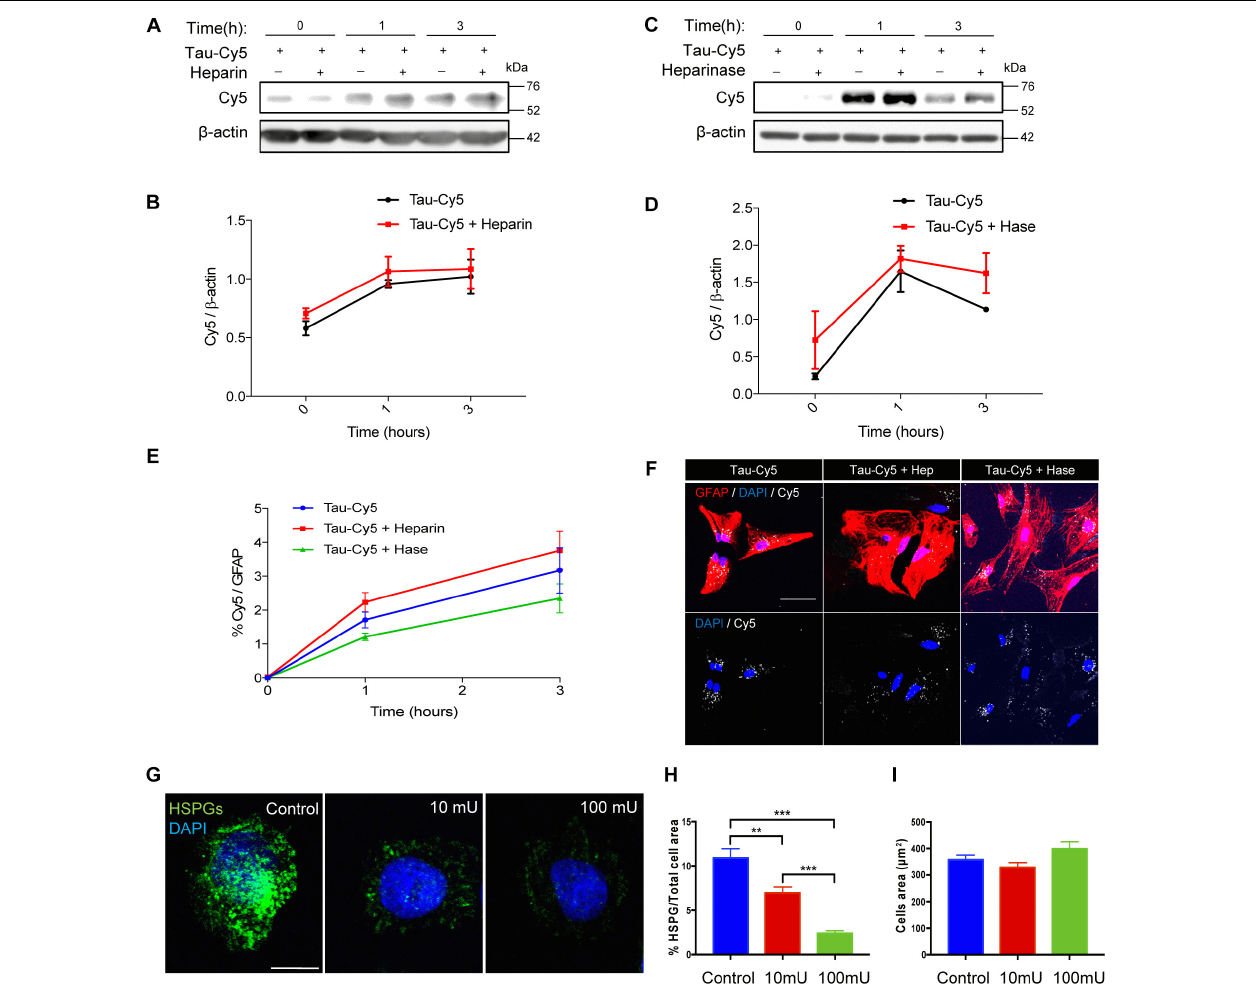
FIGURE 2 | Internalization of monomeric Tau in astrocytes is not through heparan sulfate proteoglycans. Representative western blot (A) and quantification (B) of the time course of Tau-Cy5 internalization from 0 to 3 h in the presence or absence of heparin. Cells were treated with Tau-Cy5 (control, T) or Tau-Cy5 + heparin (T+Hep) for different times, and Cy5 was analyzed in cell lysates. Note that the internalization of Tau did not change in the presence of heparin. Means and SE, T 0 h = 0.58 ± 0.06; T+Hep 0 h = 0.71 ± 0.04; T 1 h = 0.96 ± 0.03; T+Hep 1 h = 1.06 ± 0.13; T 3 h = 1.02 ± 0.15; and T+Hep 3 h = 1.09 ± 0.17. Representative western blot (C) and quantification (D) of Tau-Cy5 with (T+Hase) or without heparinase treatment (T) from 0 to 3 h. Means and SE: T 0 h = 0.23 ± 0.04; T+Hase 0 h = 0.72 ± 0.4; T 1 h = 1.65 ± 0.28; T+Hase 1 h = 1.82 ± 0.17; T 3 h = 1.13 ± 0.03; and T+Hase 3 h = 1.62 ± 0.27. Note that the internalization of Tau did not change after the treatment with heparinase. Quantification of Tau-Cy5 internalization measured by immunocytochemistry (E) and some representative images of 1 h time point after treatment (F) confirm the results obtained by western blot. Heparinase treatment reduces HSPGs (G – I) . Representative images of CHO cells treated with 0, 10, or 100 mU/ml of heparinase (G) and quantification of HSPGs (H) . Means and SE, control = 10.9 ± 1.02; heparinase 10 mU = 6.9 ± 0.67; and heparinase 100 mU = 2.4 ± 0.29. Quantification of the total area of the cells (I) support that heparinase treatment reduces the presence of HSPGs in the cells. An N = 3 independent experiments were performed. Bars show means ± SE. ∗∗ p ≤ 0.01 and ∗∗∗ p ≤ 0.001. Scale bar, 50 µ m (F) and 10 µ m (G)